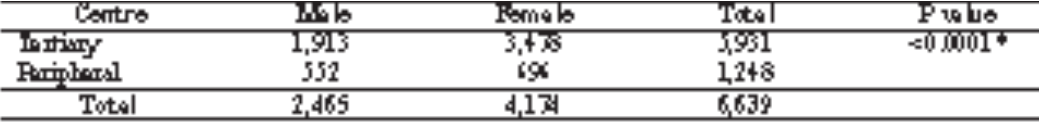
Table I: Sexwise Distribution of